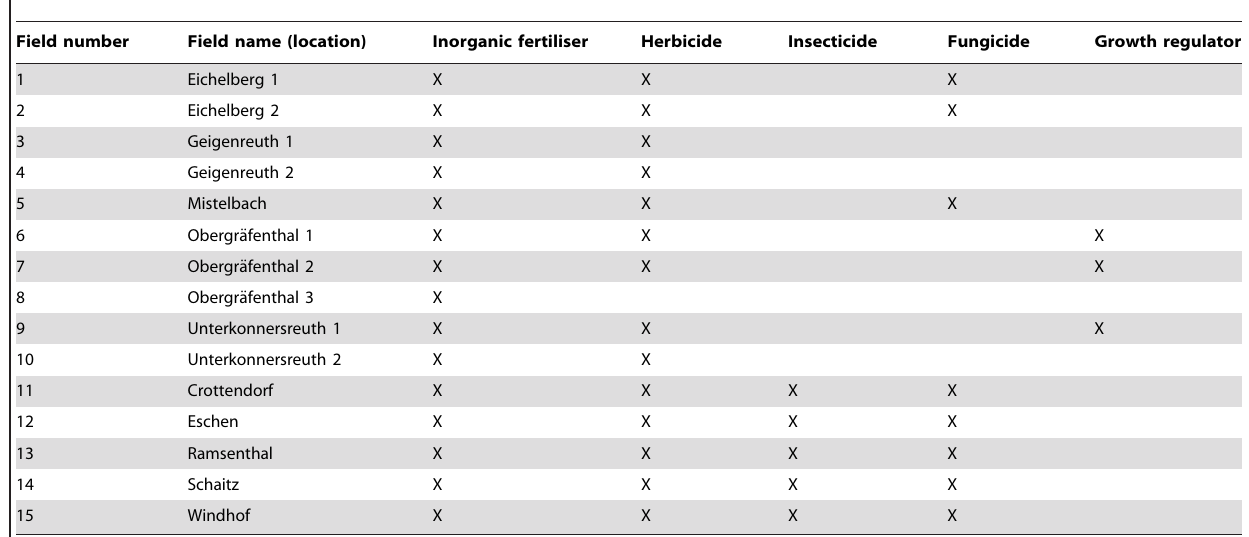
Table 1. Application of agrochemicals on conventional triticale fields in the region of Oberfranken (x= treated).